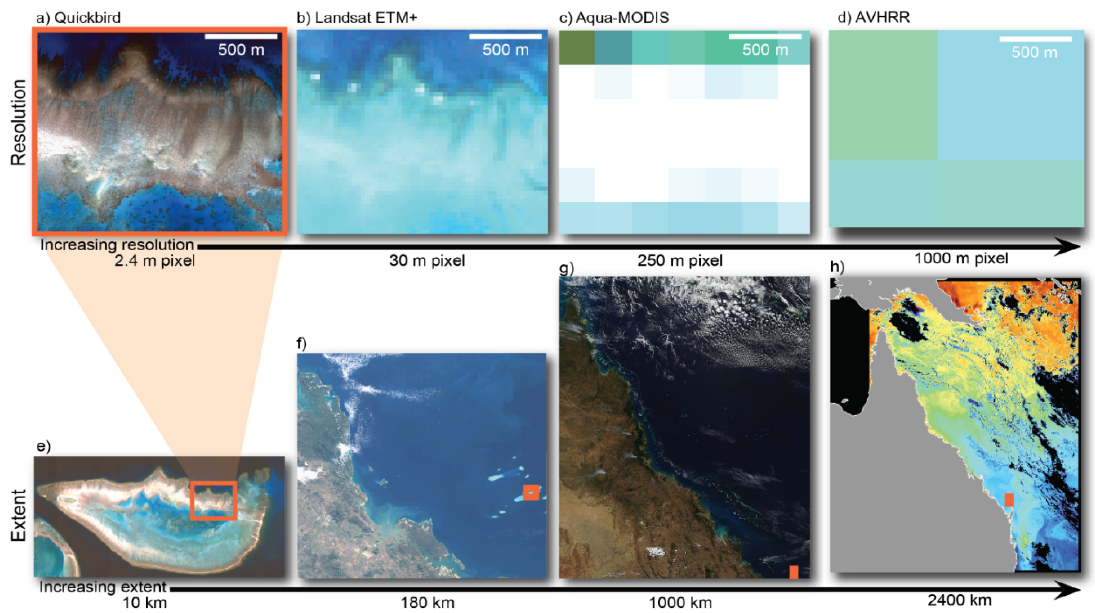
Figure 2. The different spatial dimensions of remote sensing data for an image of Heron Reef, Australia. Images ( a – d ) show the effects of progressively larger pixel sizes for a 1.5 km long section of Heron Reef, Southern Great Barrier Reef, Australia; Images ( e – g ) show different image extents; starting at Heron Reef ( e ) and moving to the entire Great Barrier Reef ( h ); Advanced Very High Resolution Radiometers (AVHRR) imagery provides information at oceanographic scale (modified from [36]).